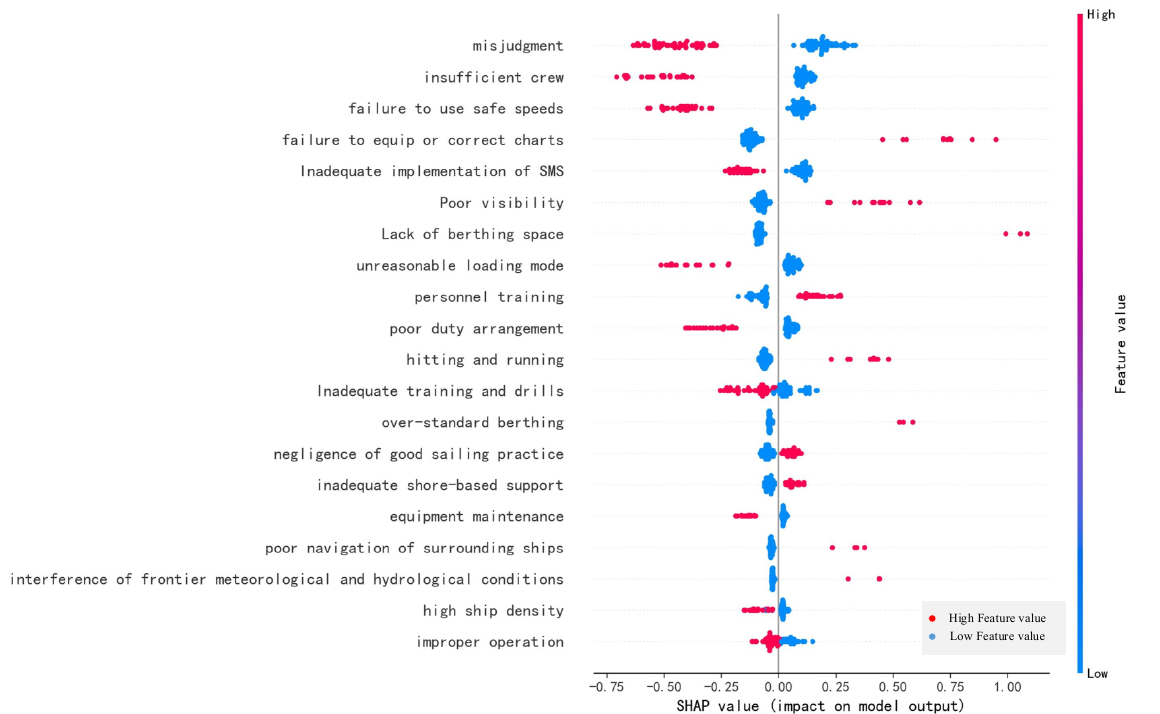
Figure 11. Scatter diagram of the comprehensive influence of the factors on ship allision accidents.